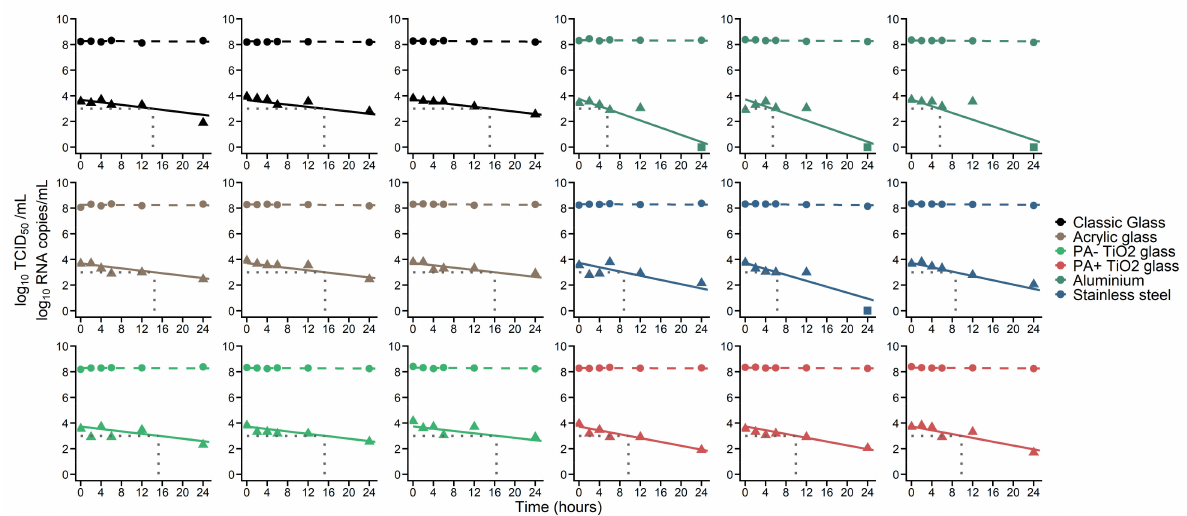
Figure 1. Individual fits of RNA and TCID 50 data. Dashed lines represent fits of RNA viral load data (circles). Plain lines represent fits of TCID 50 data (triangles). Squares represent TCID50 data under the limit of quantification. Dotted lines indicate the point the time at which TCID 50 reaches 3 log10/mL.